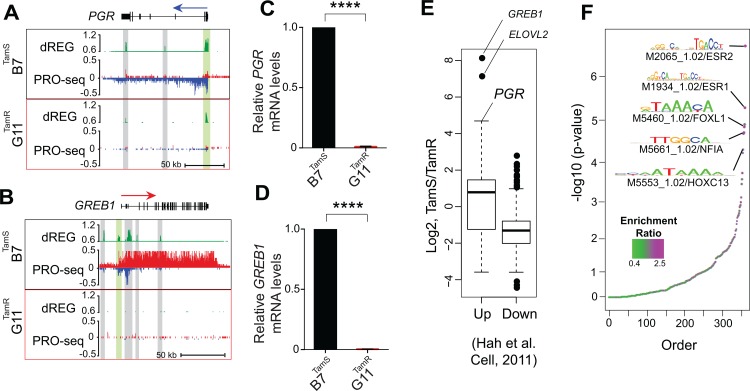
ER target genes are uniquely expressed in TamS cells.(a-b) Transcription near the PGR (a) and GREB1 (b) loci in B7TamS and G11TamR cells. PRO-seq densities on the sense and anti-sense strand are shown in red and blue, respectively. dREG scores are shown in green. Enhancers and promoters are shown in grey and light green shading, respectively. Arrows indicate the direction of gene annotations. (c-d) PGR (c) and GREB1 (d) mRNA expression levels in B7TamS and G11TamR cells. Data are represented as mean ± SEM (n = 3 for PGR; n = 4 for GREB1). **** p < 0.0001. G11TamR is normalized to B7TamS. (e) Boxplots represent fold-change between TamS and TamR of genes that are either up- or down-regulated following 40 minutes of estrogen (E2) in Hah et. al. (2011). Spearman's Rho = 0.185, p < 2.2e-16. (f) Motifs enriched in TREs that have different amounts of RNA polymerase between TamS and TamR cells compared with TREs that have consistent levels.